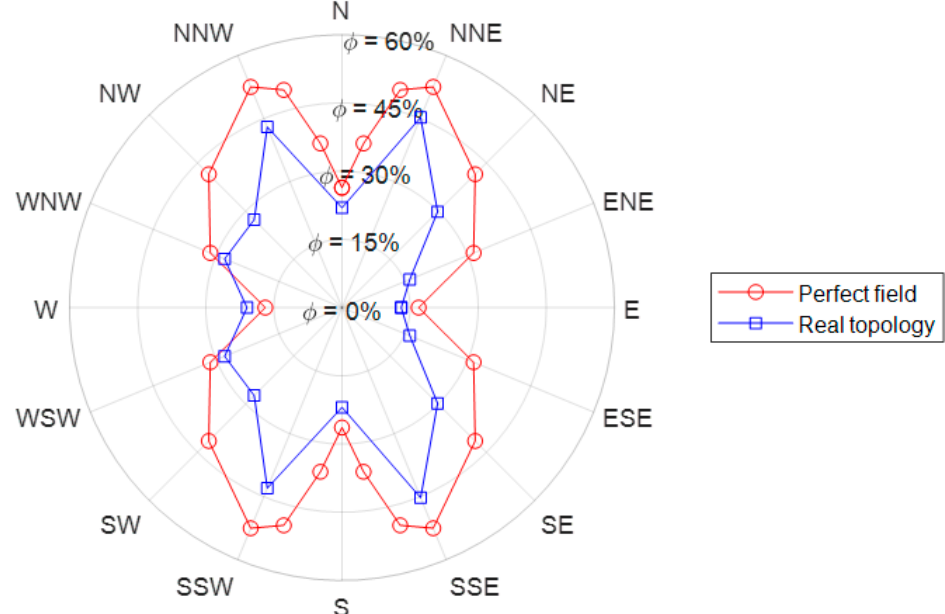
Figure 21. Global recirculation at the intakes of the evaporators, uniform field (red) and real topology